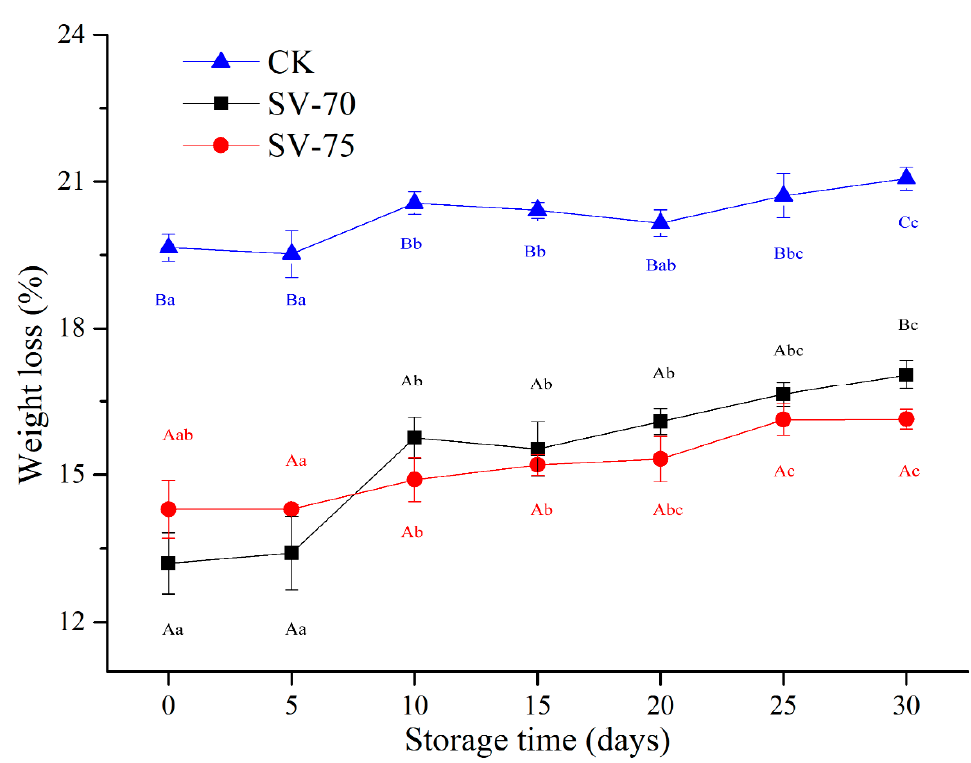
Figure 3. Changes in weight loss of scallop muscle with different treatments during 30 d of chilled storage. Different lowercase letters in the same color for the same point plot indicate significant difference ( p < 0.05), and different uppercase letters in the same storage time indicate significant difference ( p < 0.05).